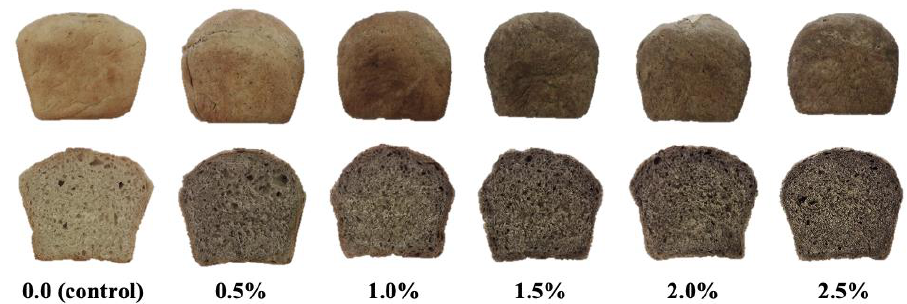
Figure 1. The appearance of the loaves and crumb of the tested wheat breads.